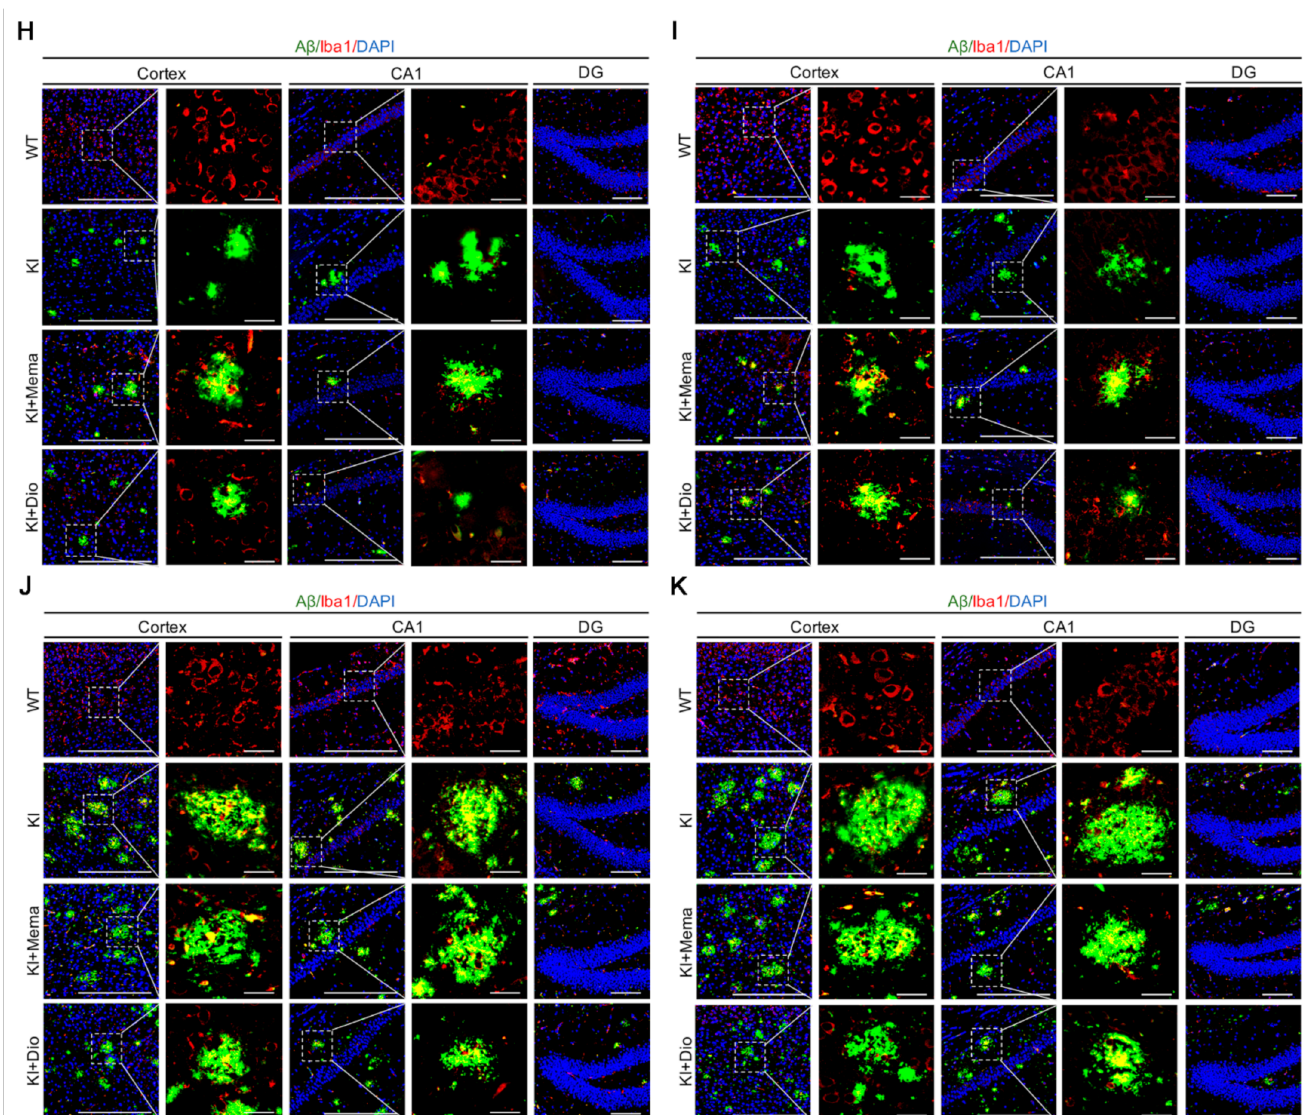
Figure 4. Effect of Dio on microglial activity in young App NL-G-F mice. ( A – C ) Images and quantification showing Iba1 staining in the cortex and hippocampal CA1 region in 3 and 6-month-old male and female WT and App NL-G-F mice. Scale bar: 0.1 mm. Data are expressed as mean ± SEM. n = 3 slides/group. Four randomly selected fields of view for each section under a microscope. *** p < 0.001 compared with WT. ## p < 0.01 compared with App NL-G-F ; ### p < 0.001 compared with App NL-G-F ; ( D ) TEM image from 6-month-old male and female WT and App NL-G-F mice showing microglia. Scale bar: 5 µ m; ( E – G ) Western blot and quantification of Iba1 protein expression in the cortex and hippocampus in 3- and 6-month-old male and female WT and App NL-G-F mice. Data are expressed as mean ± SEM. n = 6 mice/group. * p < 0.05 compared with WT; ** p < 0.01 compared with WT; *** p < 0.001 compared with WT. # p < 0.05 compared with App NL-G-F ; ( H – K ) Merged immunofluorescence images of Iba1, A β and DAPI staining in the cortex and hippocampus of 3- and 6-month-old male and female WT and App NL-G-F mice. Scale bars: 1 mm and 0.1 mm; ( H ) 3-month-old male mice; ( I ) 3-month-old female mice; ( J ) 6-month-old male mice; ( K ) 6-month-old female